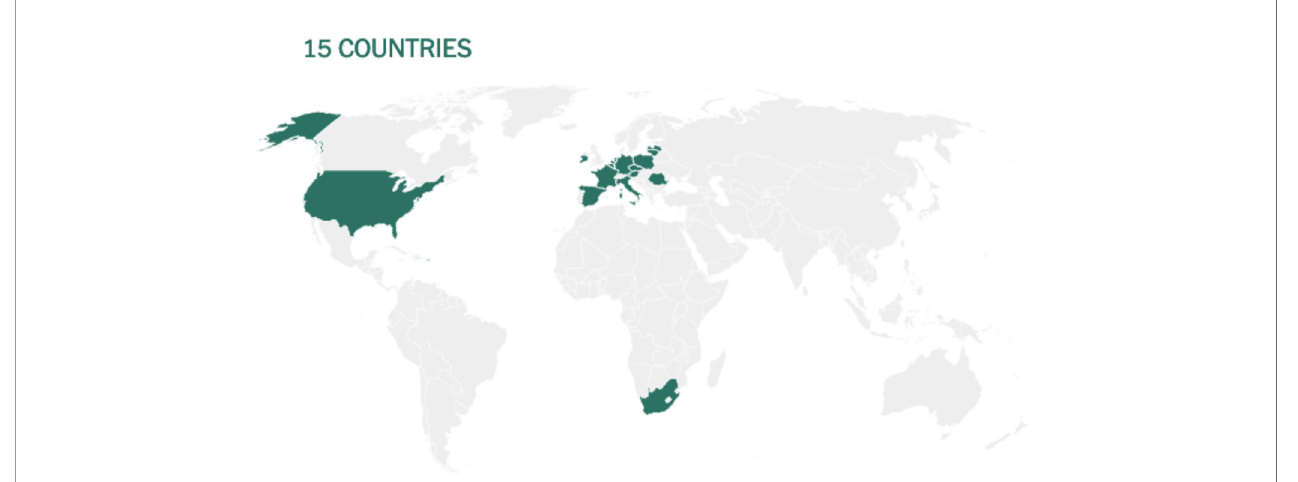
FIGURE 12 | Countries where the Ad26.COV2. S-Jansen (Johnson&Johnson) vaccine is being used as of May 10, 2021. Source: Our World in Data (https://